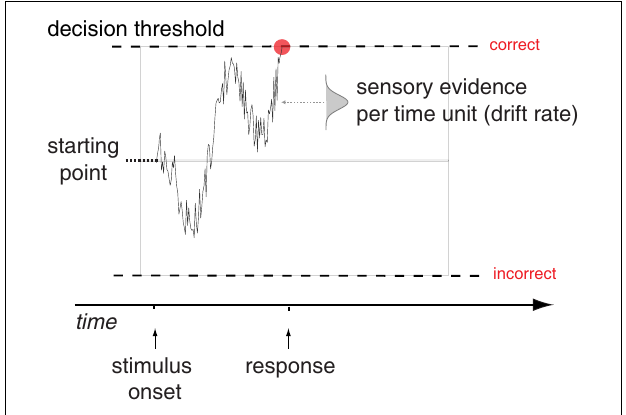
FIGURE 1 |The Drift Diffusion Model. Schematic illustration of the main components of the Drift Diffusion Model, showing a sample path for trial where a correct decision is made. Figure adapted from Mulder et al.